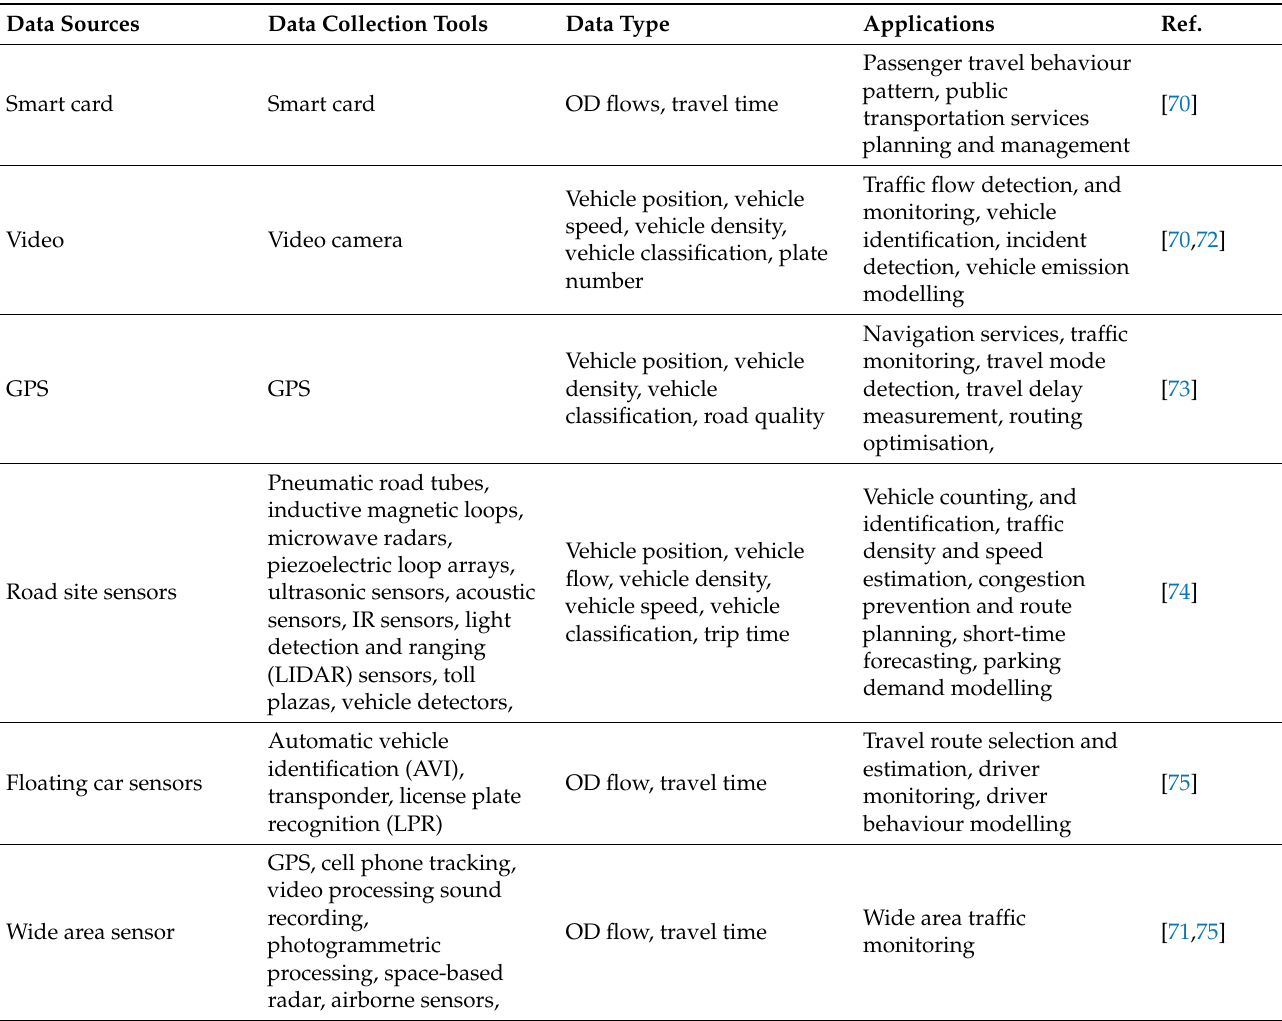
Figure 17. Data collection sources for SC transportation strategies. Table 2. Summary of transportation data collection sources and